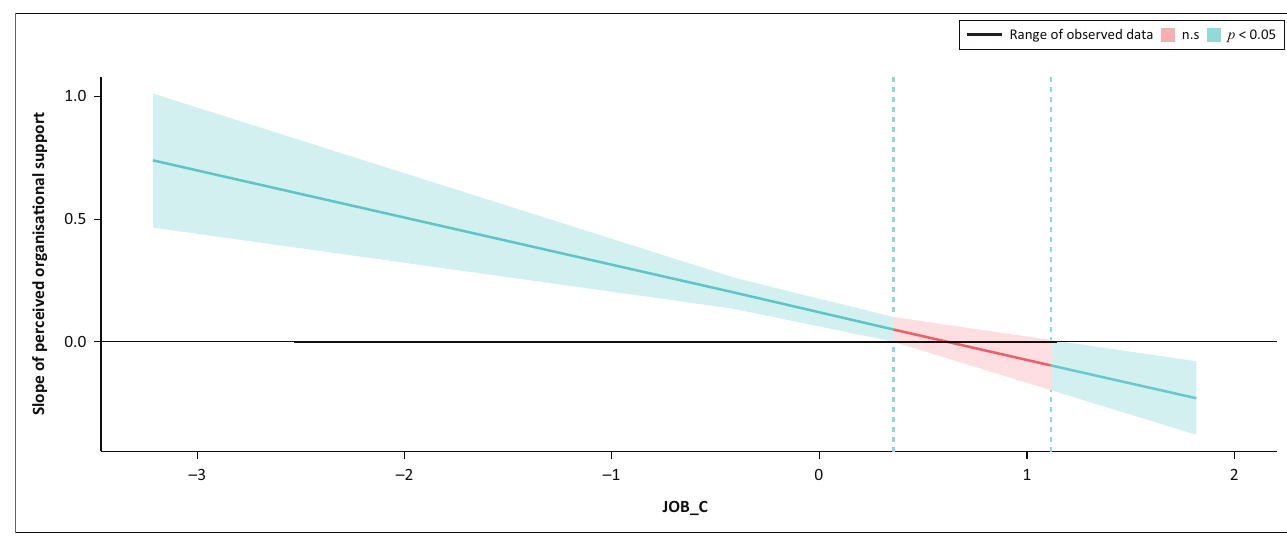
FIGURE 2: The Johnson–Neyman